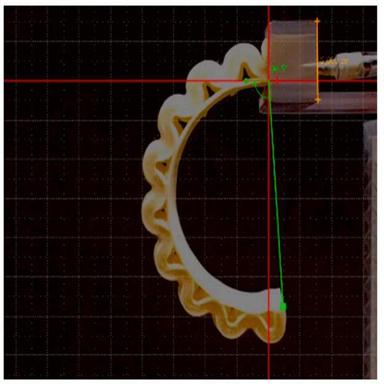
Displacement analysis (20 psi).